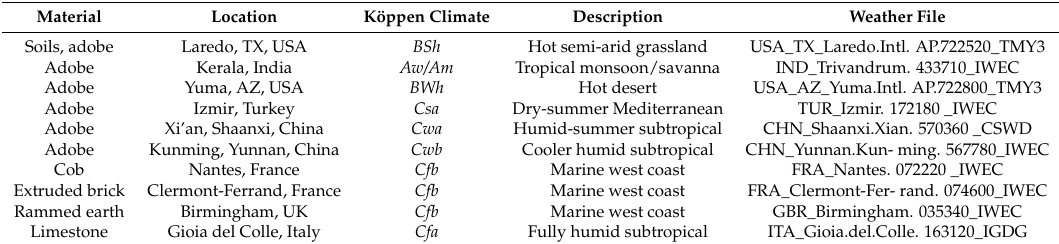
Table 3. Earth building materials and